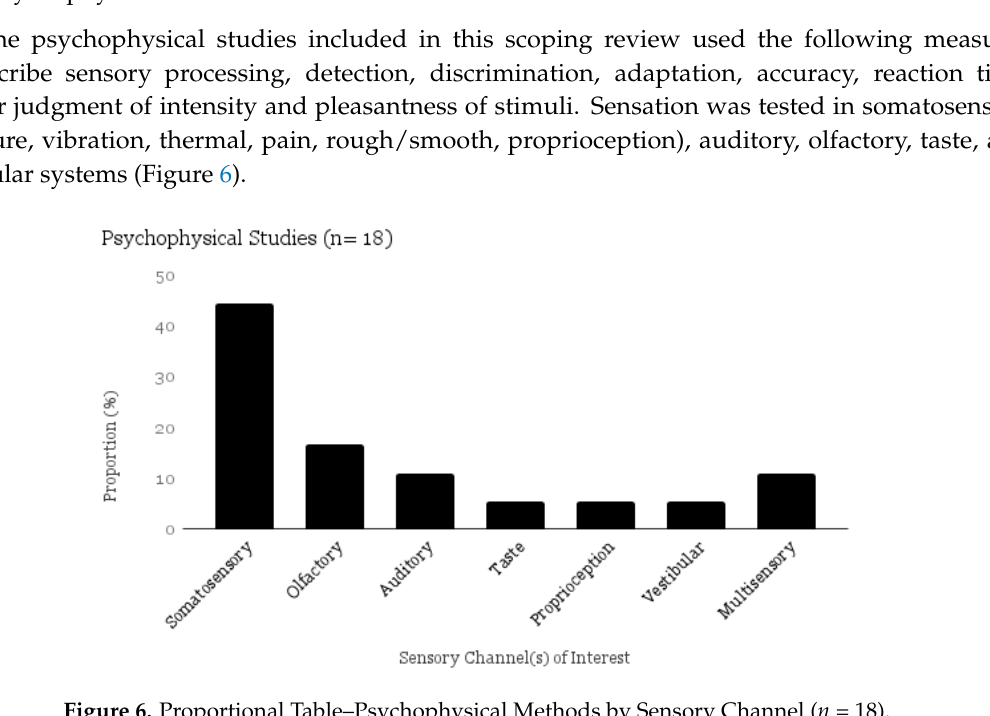
Figure 6. Proportional Table–Psychophysical Methods by Sensory Channel ( n = 18).